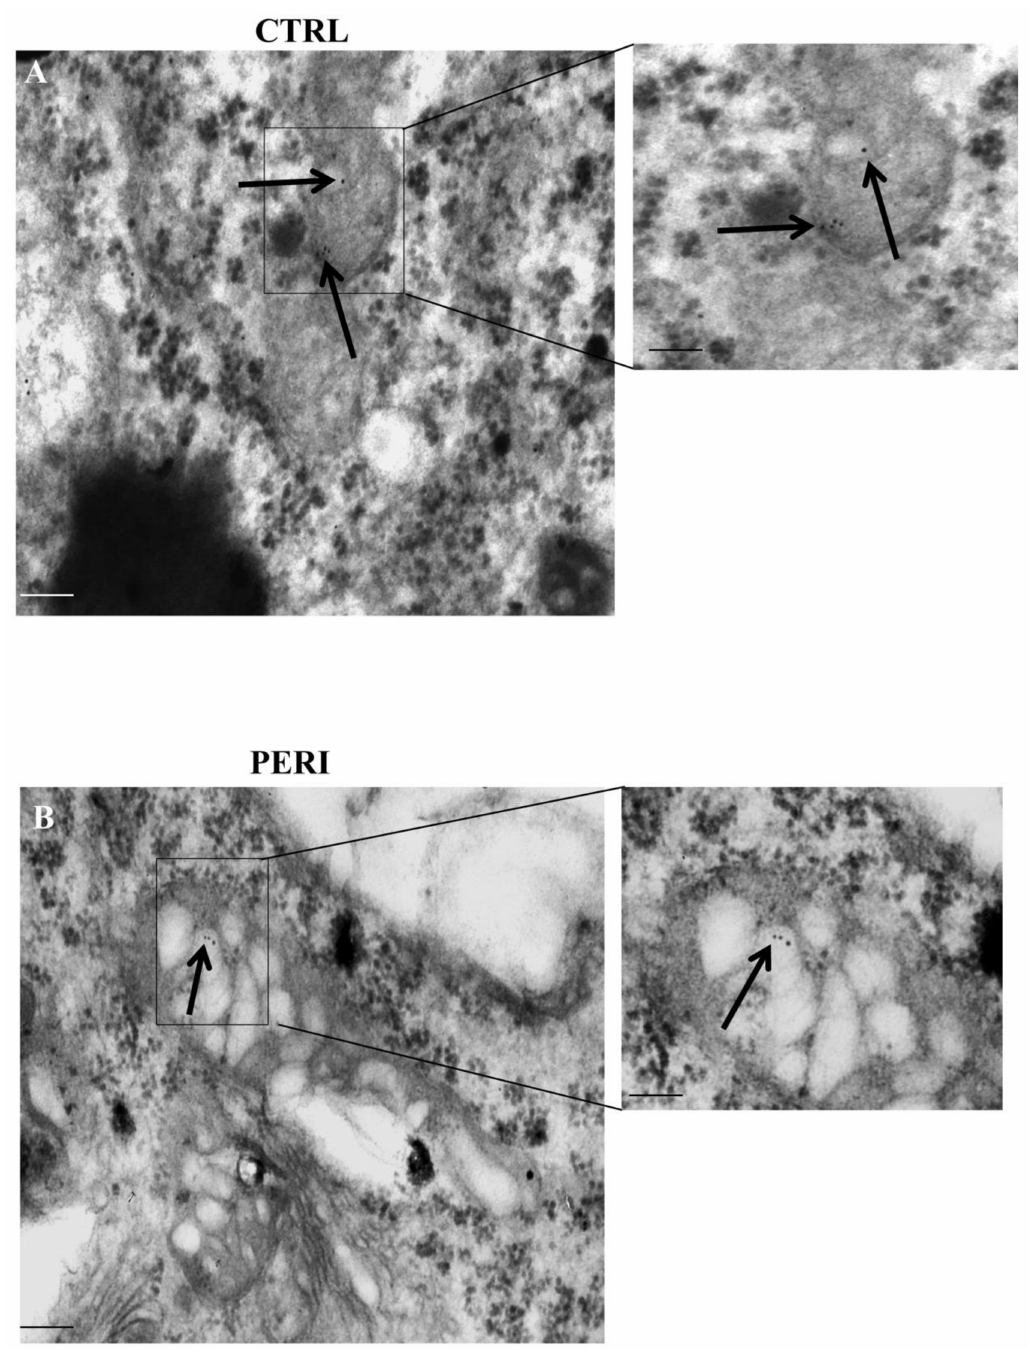
Figure 8. Representative polarization for HSP70 within mitochondria. Representative TEM micrograph showing a HSP70- positive mitochondrion from the control cortex ( CTRL ) and the penumbra cortical area ( PERI ). Arrows point to HSP70 immuno-gold particles within mitochondria. The insert highlights the immuno-gold particles within mitochondria. Scale bar = 0.2 µ m (low magnification), 0.1 µ m ( inserts